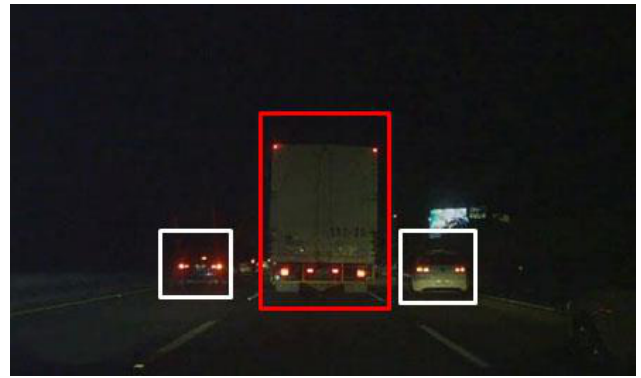
Figure 21. Regions for tracking after classification.